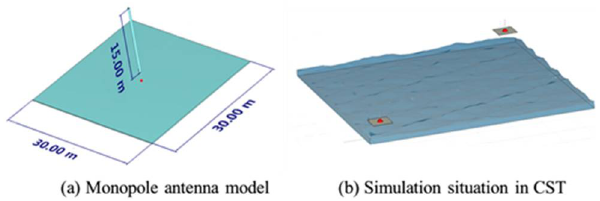
Figure 11. Monopole antenna model and radio propagation simulation schematic diagram, where the GND is a 30 m × 30 m square, and the pole’s length equals to 15 m.